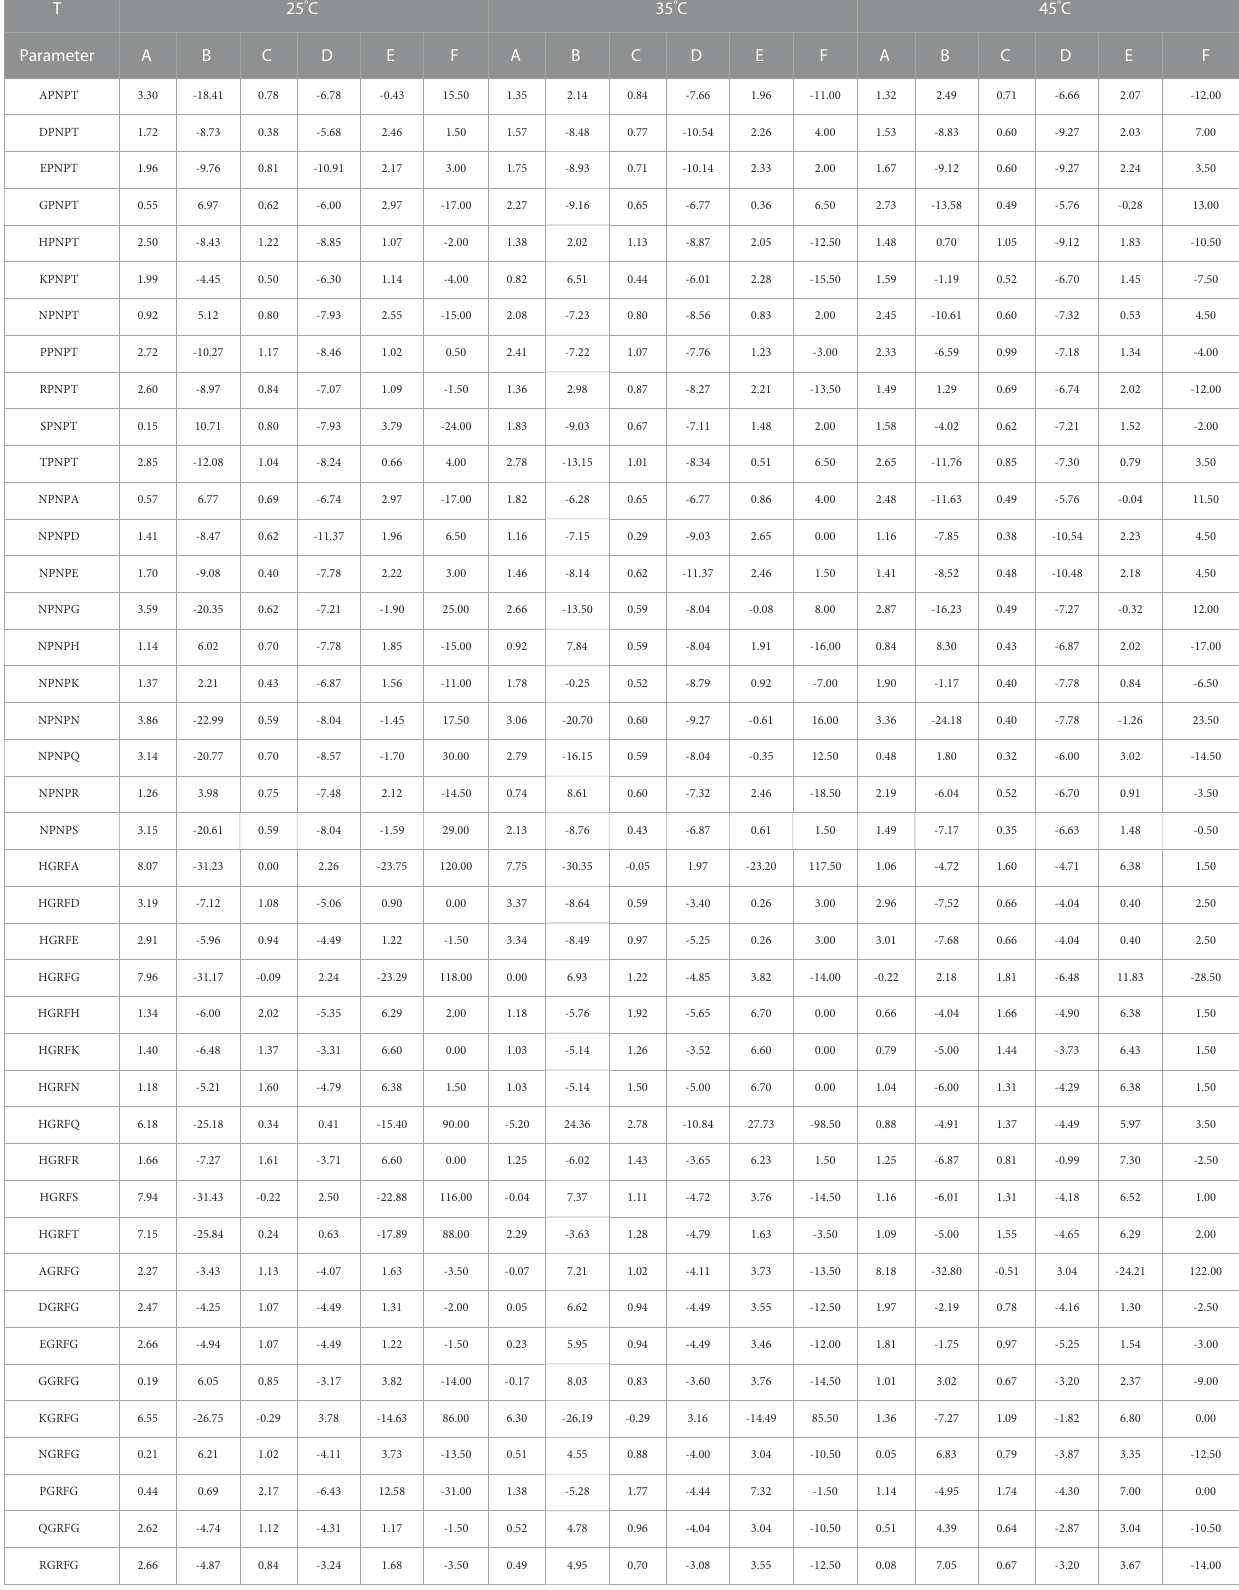
TABLE 6 Parameter results of fi tting with φ and pH at different temperatures. T 25 °